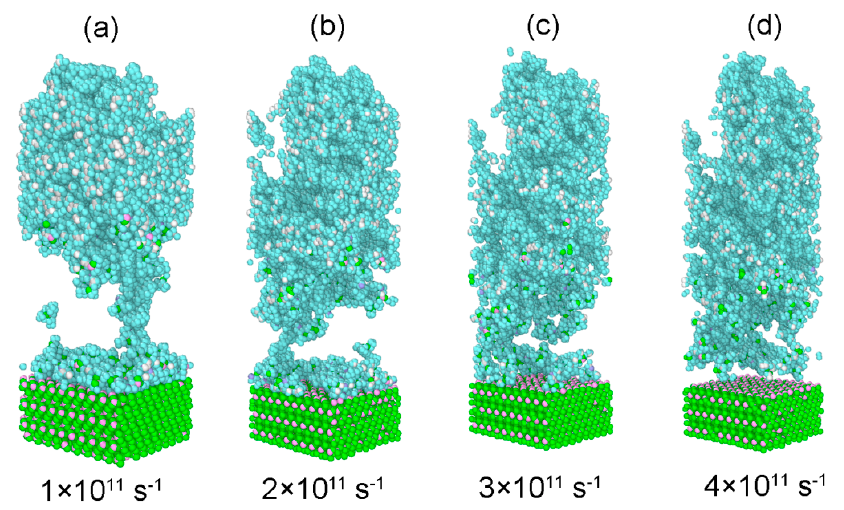
Figure 15. Snapshots of the deformation of the glass fiber/PP material system at the final strain of 100% at various strain rates with the loading temperature of 298 K.